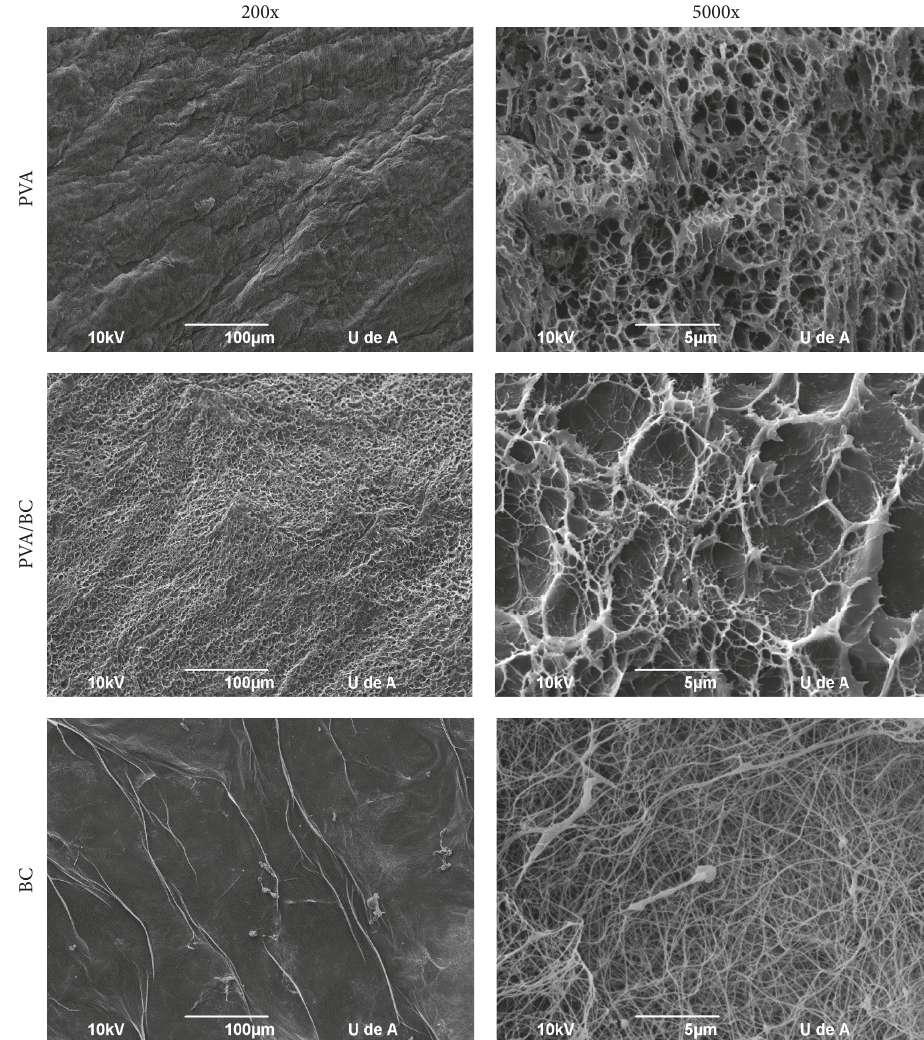
Figure 1: Microstructure of the dry biomaterials obtained from for PVA, PVA/BC nanocomposite, and BC as assessed by scanning electron micrographs at different magnifications (200 and